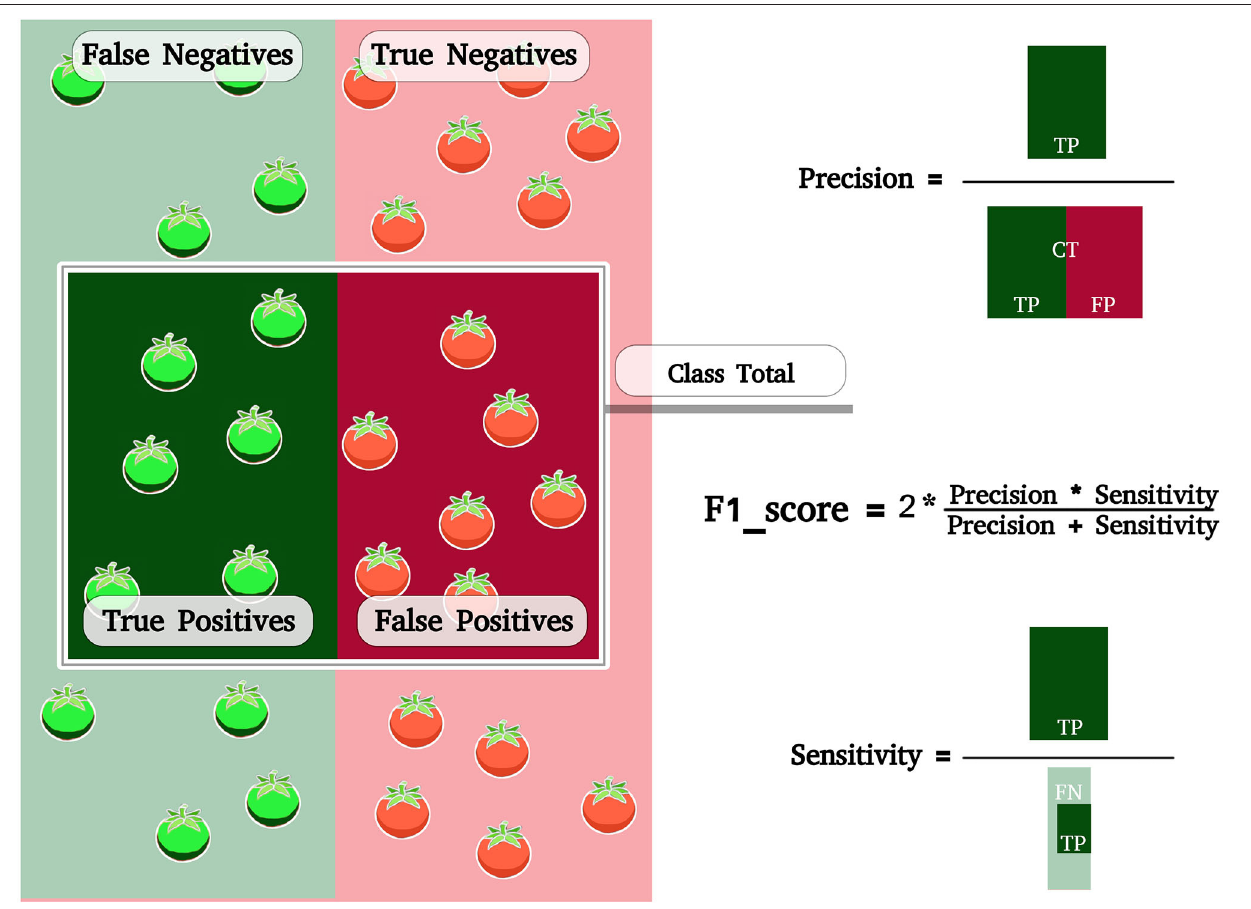
FIGURE 3 | Scheme representing the sample space submitted to ML classification. Class Total is the region where the ML has classified green. The green tomatoes within the classification region are correct. Red tomatoes within the region were classified as non-red. A true positive is a result where the model correctly predicts the class. A false positive is a result where the model incorrectly predicts the class. A false negative is when the model incorrectly predicts the wrong class. CT, Class Total; TP, True Positives; FP, False Positives; FN, False